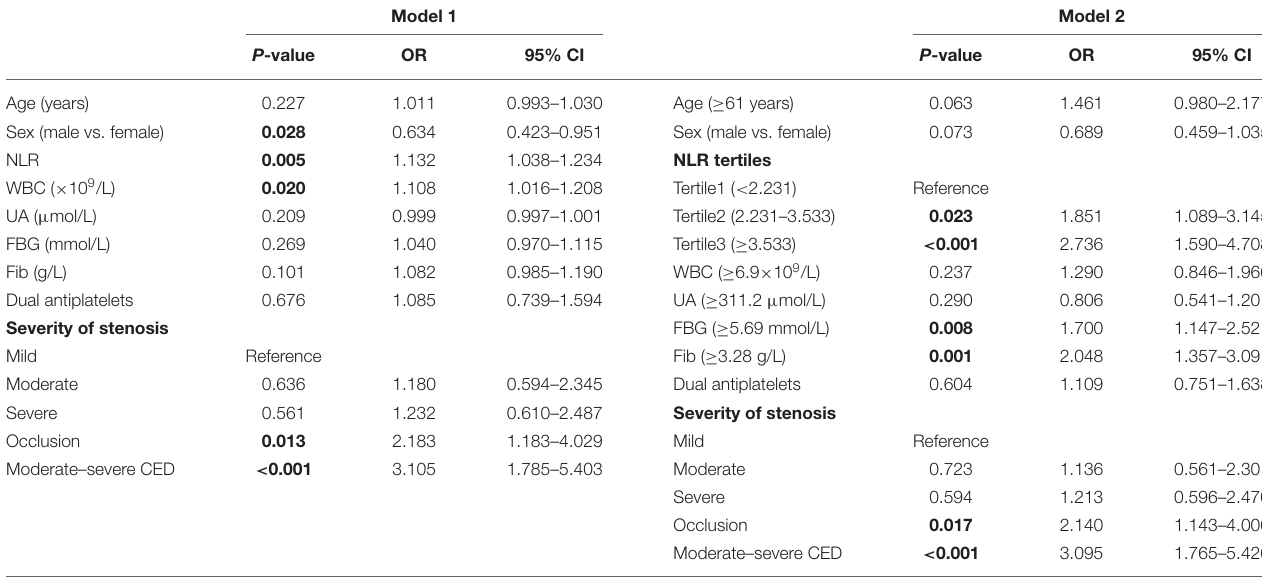
TABLE 3 | Multivariate logistic regression analysis of the relationship between NLR and the initial stroke severity of sICAS. Model